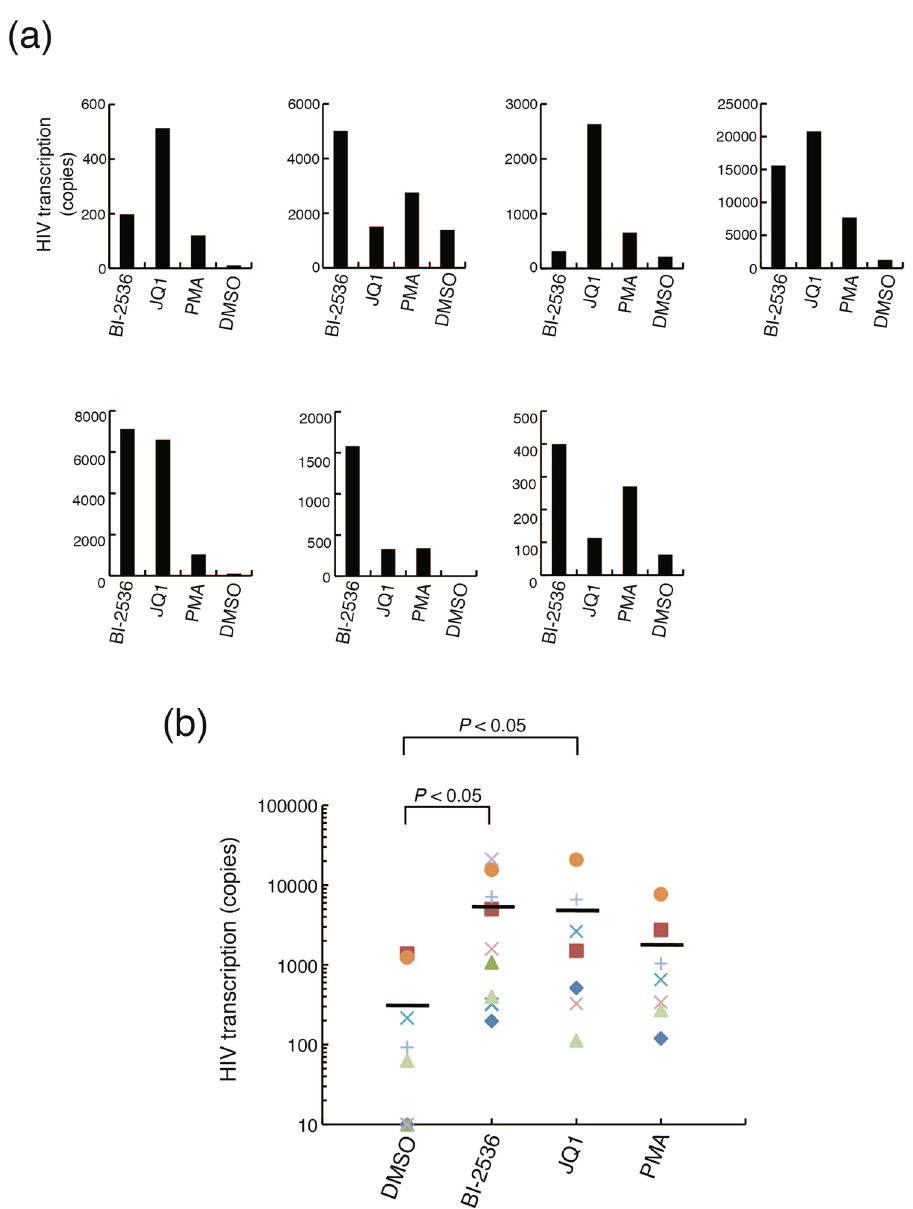
Figure 7. Latent HIV-1 proviruses in primary cells from infected patients have different responsiveness to BI- 2536 and JQ1. ( a ) Peripheral blood mononuclear cells (PBMCs) derived from seven different HIV-1 patients were expanded in the presence of IL-2 and PHA. The cells were then cultured in 0.1% dimethyl sulfoxide (DMSO) and untreated or treated with 1 μ M BI-2536, 1 μ M JQ1, or 10 ng/mL phorbol-12-myristate-13- acetate (PMA) for 16 hours. Total RNA was prepared from the cells. Gag mRNA expression was measured by quantitative RT-PCR. Viral copy number per one million cells was shown as the mean of triplicate determination. ( b ) Statistical analysis was conducted on the data shown in ( a ). The horizontal lines show the mean of the samples treated with each regent. P -values were determined using the Mann-Whitney U test for nonparametric data. P -values are significant if less than